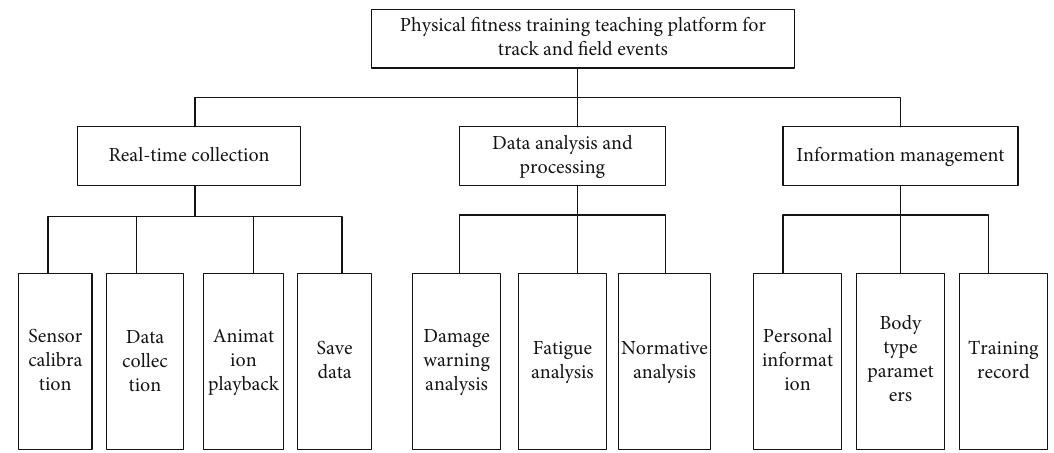
Figure 1: The structure diagram of the teaching platform for physical training of track and fi eld events. Table 1: Teaching platform database fi eld settings.